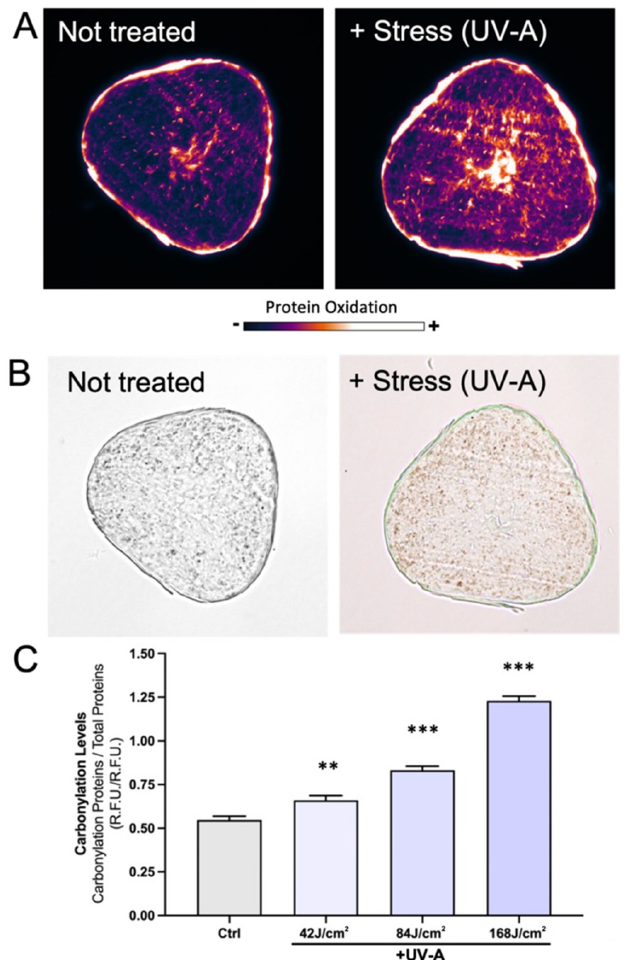
Figure 1. Structural Proteins Carbonylation on hair fibers upon UV-A irradiation . ( A ) Epi-fluorescence imaging of carbonylation in hair fibers cross-sections. Carbonylation levels are presented as a gradient of colors (not treated on the left, stress exposed on right; from dark color for low levels to bright colors for high levels of carbonylation). ( B ) Melanin clusters visualization on the same samples. Non-treated or stressed hair fibers are detected by brightfield optical microscopy (in gray scale color, on the left) or in RGB color representation. ( C ) Protein carbonylation quantification upon protein extraction and resolution onto SDS-PAGE. Statistics: ANOVA and Dunnett’s post-hoc multi-comparison test versus Control (Ctrl), ** p < 0.01 *** p < 0.001.